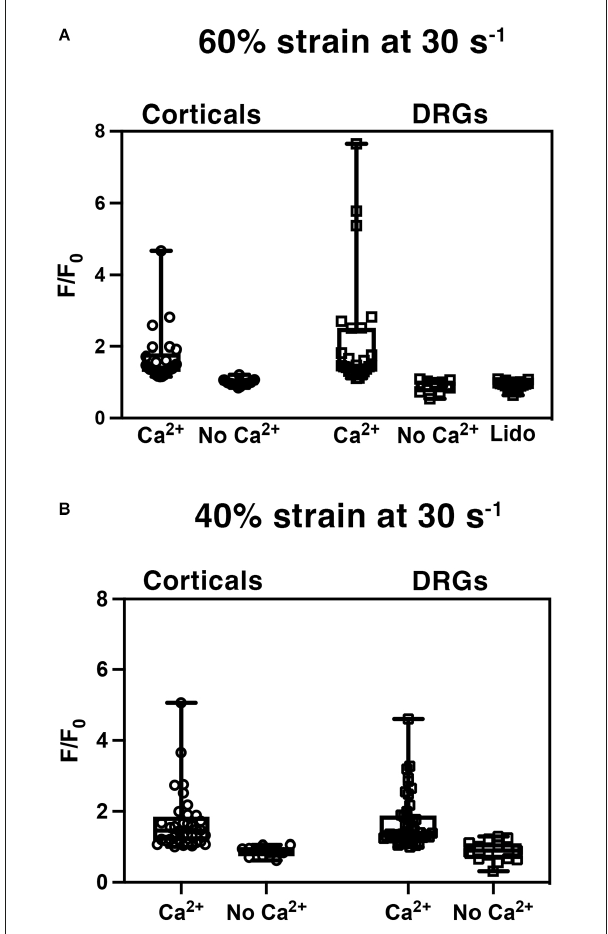
FIGURE4 Stretch injury induced increase in intracellular calcium (Ca 2+ ). Normalized fluorescent intensity values (F/F 0 ) in DRGN and cortical axons after (A) injuries at 60% strain at a rate of 30 s − 1 , and (B) strain of 40% at a rate of 30 s − 1 . Cultures were injured with the presence of extracellular Ca 2+ and without -Ca 2+ . DRGN cultures treated with lidocaine (Lido) blocked the injury related influx of